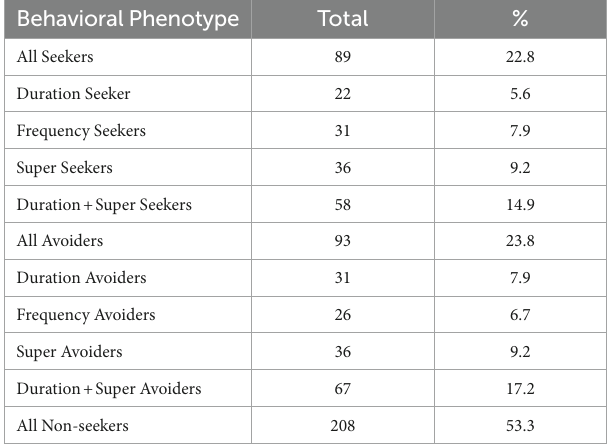
TABLE 1 Behavioral Phenotypes in a Cohort of 390 larval zebrafish